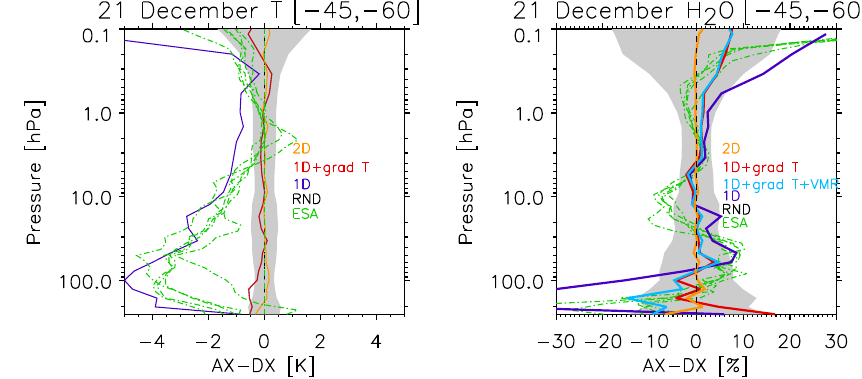
Figure 2. AX–DX differences for 21 December 2011 in the 45–60 ◦ S latitude band for T and H 2 O. The line colours show the differences from ESA IPF V6.0 Level 2 MIPAS data in December 2005 to 2010 in green, the 1-D retrievals in blue, the 1-D retrieval with T gradients in red, the 1-D retrieval with gradients of T and target species in cyan and the 2-D retrievals in orange. The grey shadow represents the average ORM (optimised retrieval model) random error (RND).